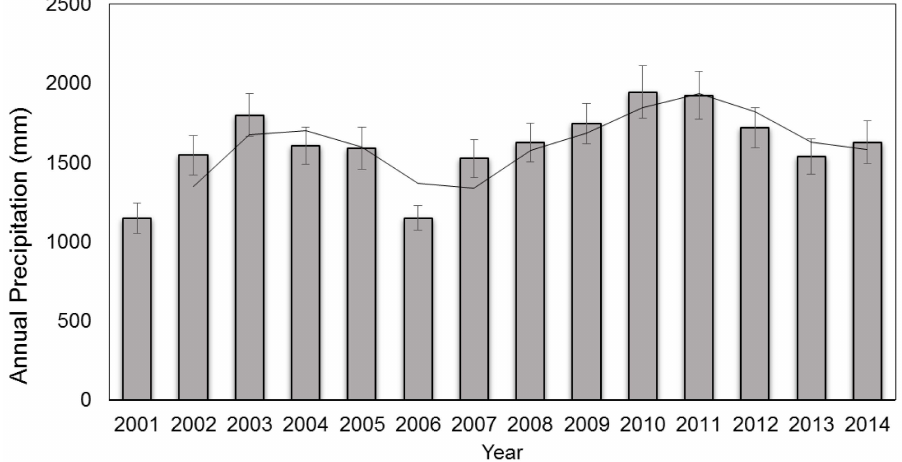
Figure 3. Annual precipitation in El Salvador between 2001 and 2014.